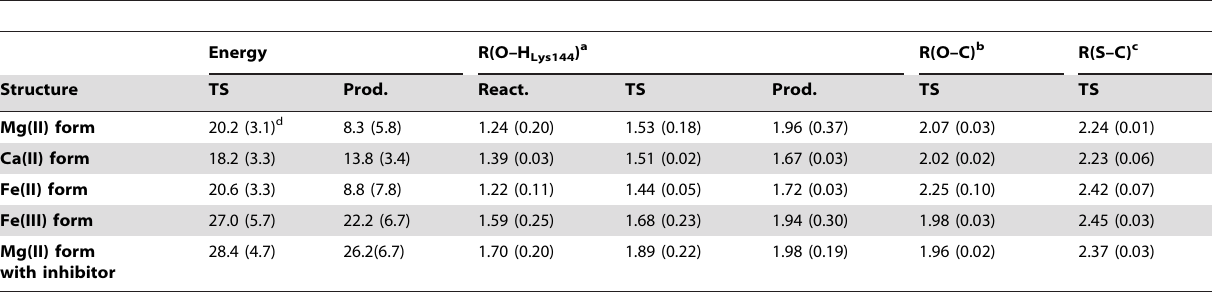
Table 2. Averaged over the QM/DMD ensembles energies (ZPE-corrected), and structural parameters (in A˚) of the stationary points along the methyl transfer path, for the Mg(II), Ca(II), Fe(II), and Fe(III) forms of COMT, with the catechol substrate, and the Mg(II) form with the